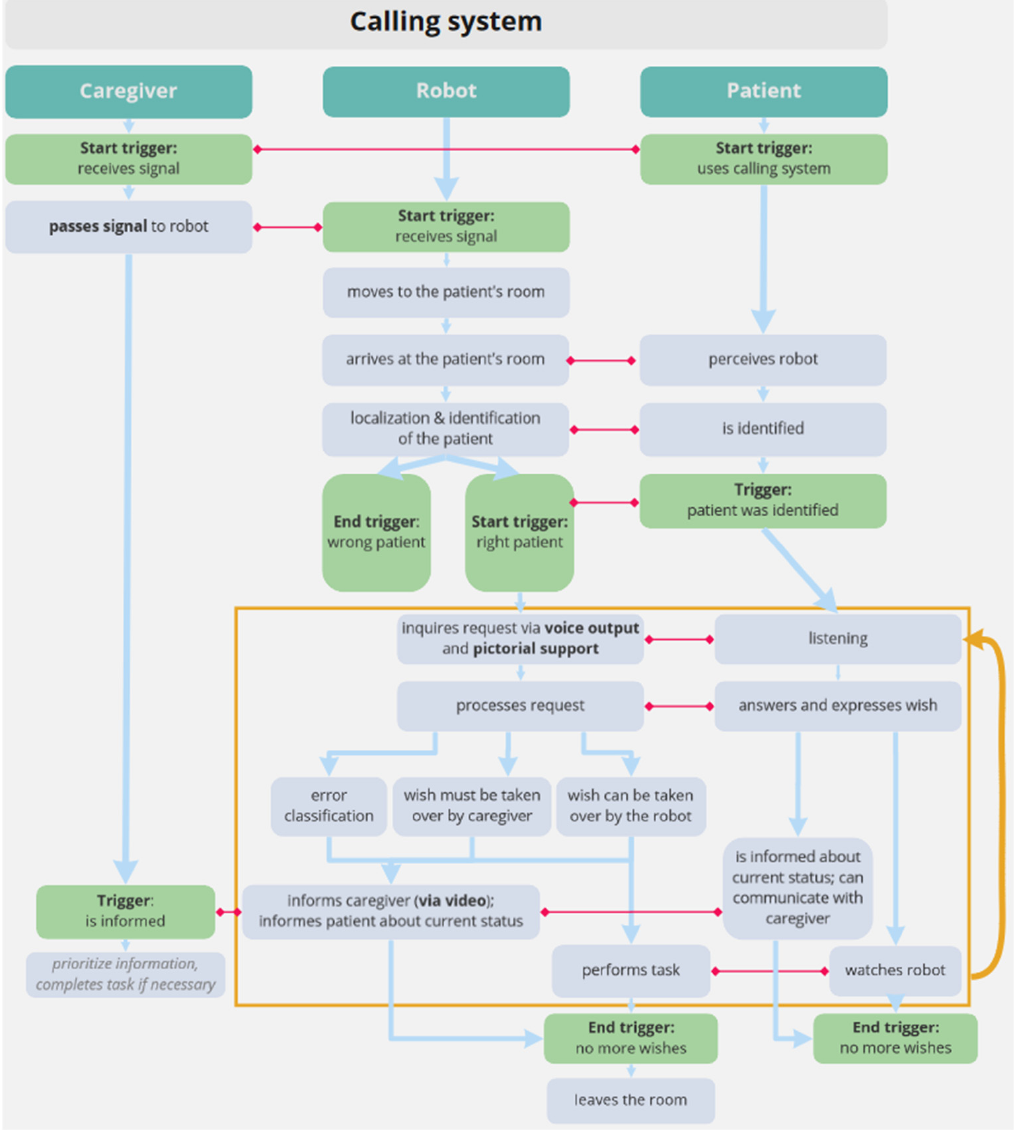
Figure 9. Sequence model of the calling system.